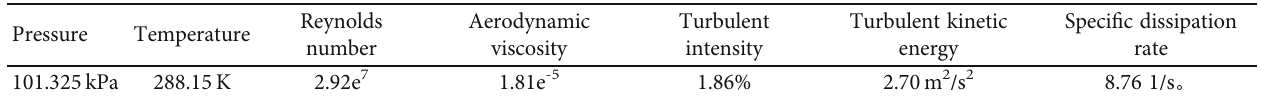
Figure 2: The A330-200 wing partial grid. (a) Grid at the leading edge of the wing and (b) grid at the winglet. Table 2: Fluid parameter